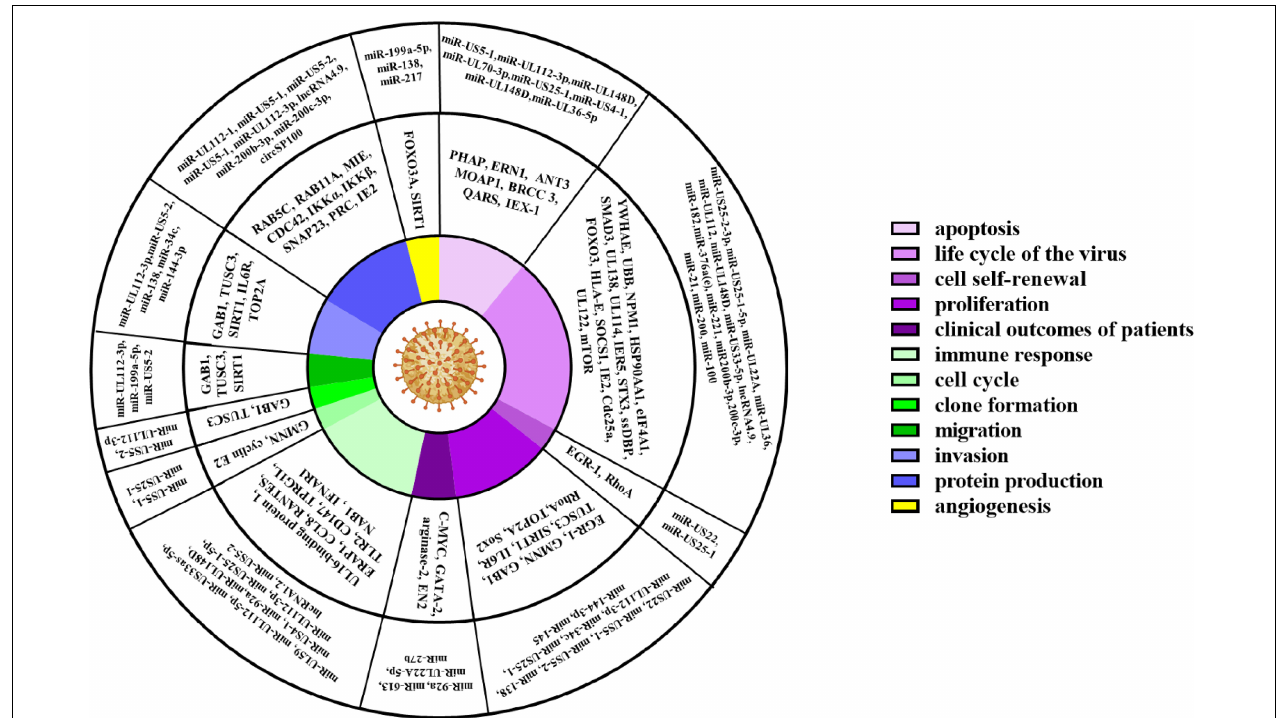
FIGURE 2 | HCMV associated cellular events, and key proteins,